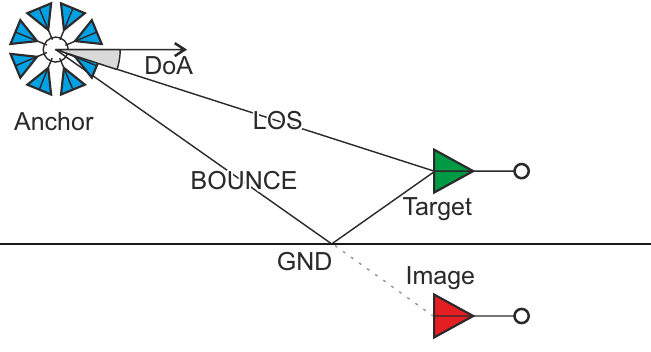
Figure 4. Pictorial rendition of the multipath-impaired scenario for the DoA estimation.